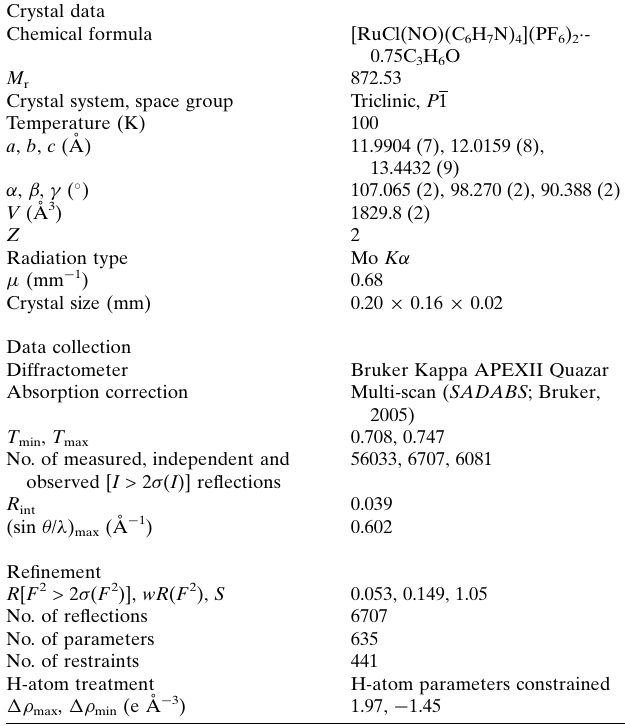
Crystal data Chemical